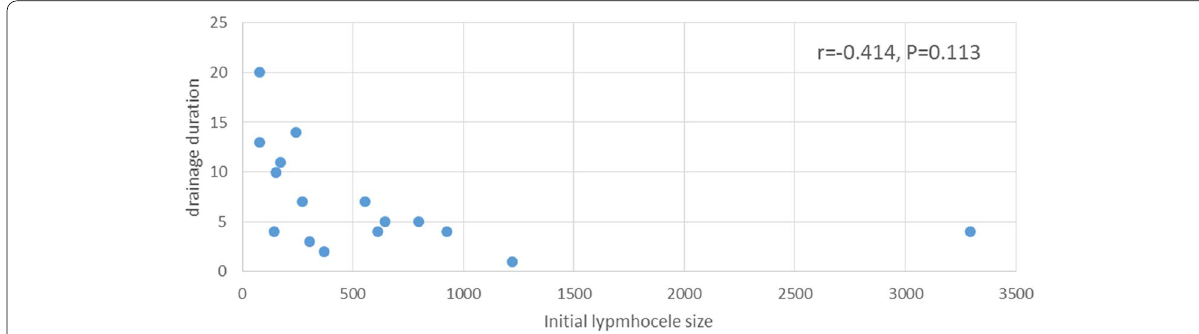
Fig. 2 Correlations between initial lymphocele size and drainage duration